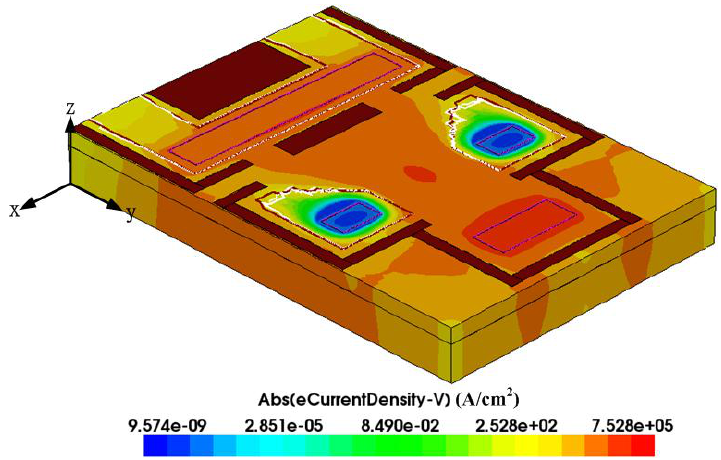
Figure 4. Carriers density of the magneto-transistor in a 250 mT magnetic field.